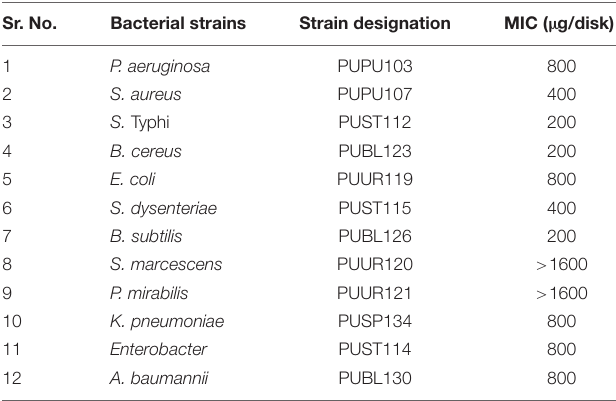
TABLE 1 | Antibacterial activity of lawsone from P. zeylanica ethanol root extract. Sr.